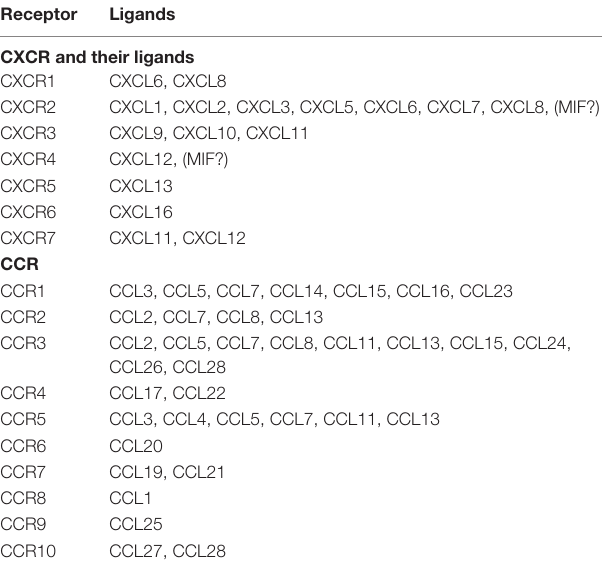
TABLe 1 | Key chemokine receptors and their